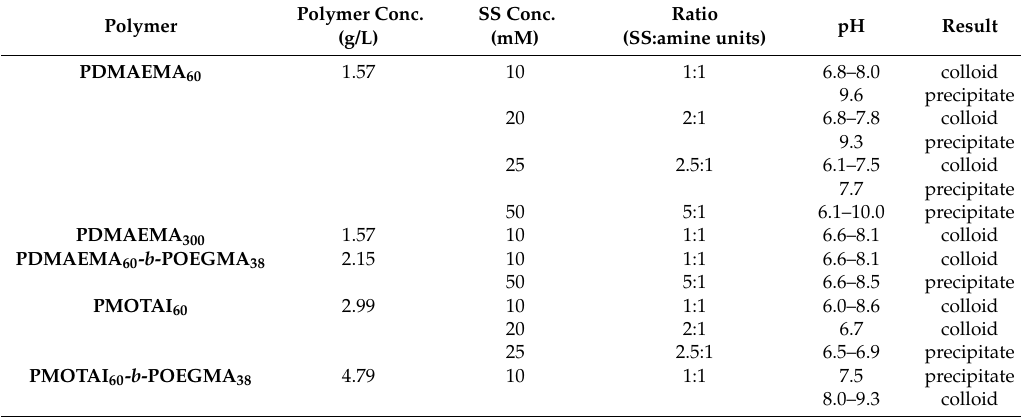
Table 3. Colloid (water-dispersible) and precipitate S-PE composites, as prepared in this work under different conditions of pH, with respect to the initial ratio of SS/amine repeating units. The concentration of amine repeating units in all cases is 10 mM. Four components were used in the preparation of all S-PE composites: sodium silicate, polymer, hydrochloric acid and deionized water. Colloids are defined as those S-PE composites which remained stable in aqueous dispersion for at least 7 days. The total initial volume of each solution was 2 mL. The pH of the solution was adjusted by addition of the appropriate amount of (0.1 or 1.0 M) HCl. A range of pH values are shown to illustrate the maximum and minimum values of pH in a